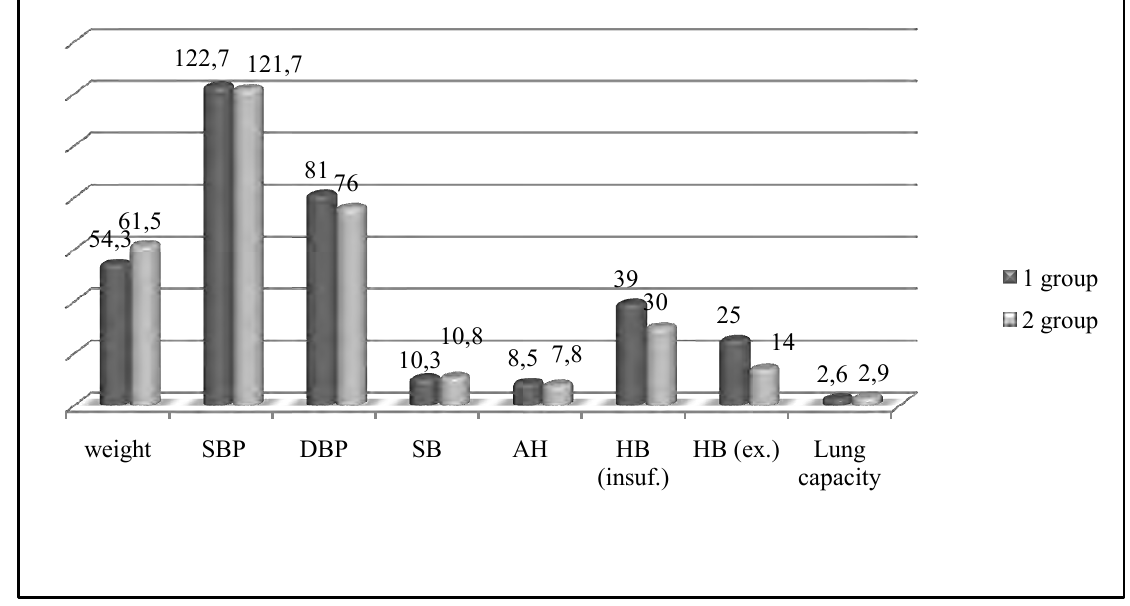
Fig. 2. Results of measuring of 30-35 years old women’s functional